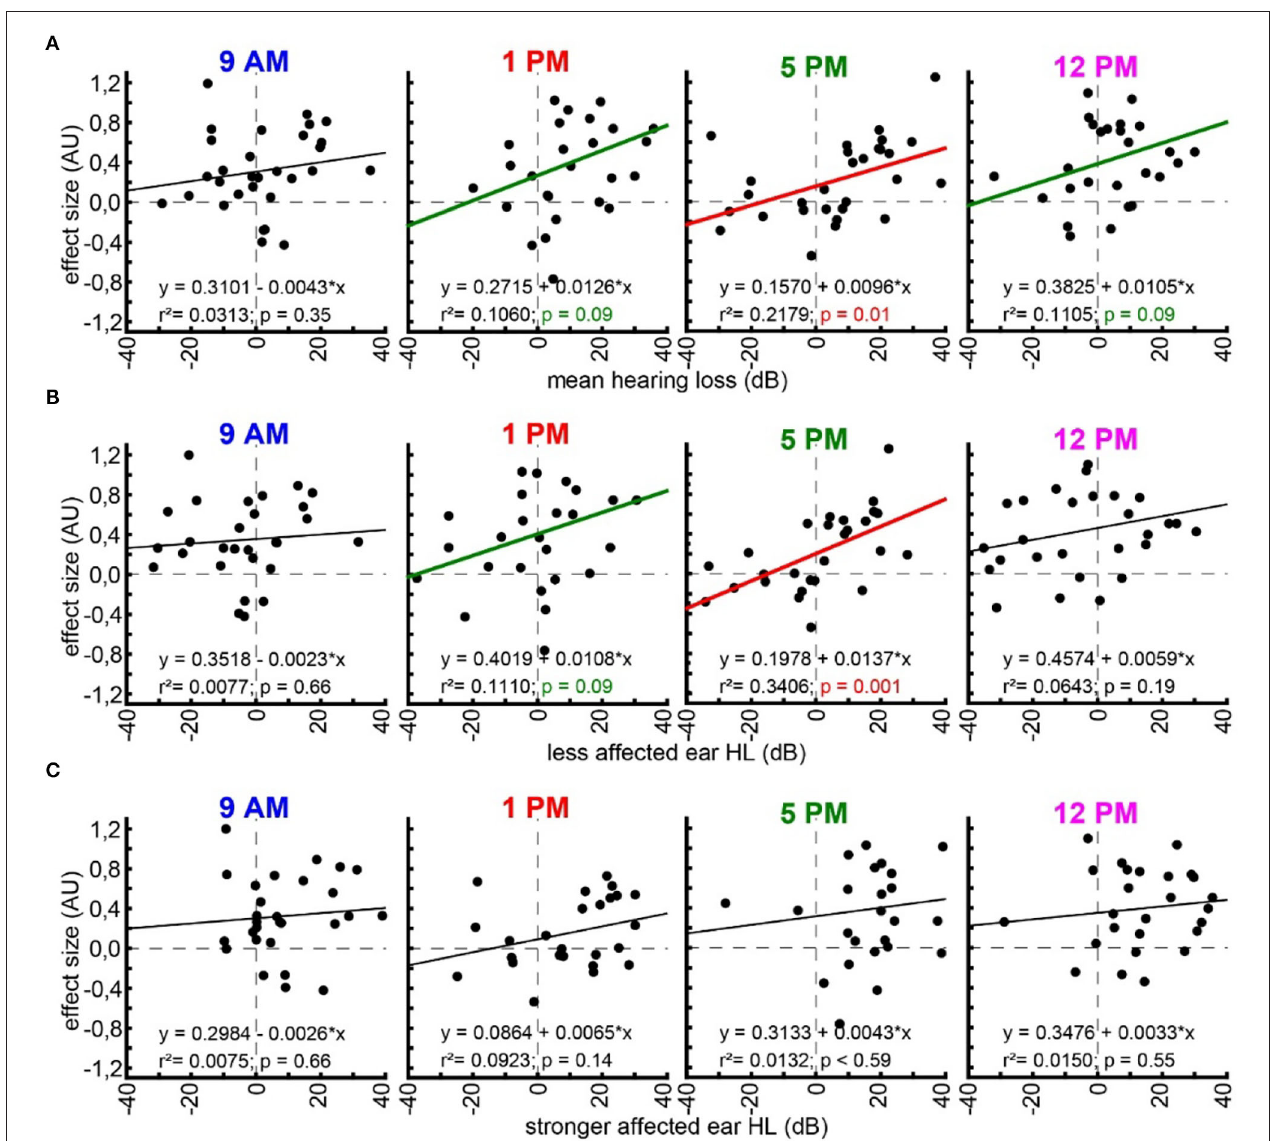
FIGURE 5 | Linear regression analyses of hearing loss and effect size. (A) Multiple linear regressions for effect size and mean binaural hearing loss for each trauma time group (panels from left to right). Linear regression formula, r ² -value, and p -value are given for each case. Black regression lines and p -values indicate no significant regression, green indicated a tendency, and red indicates a significant regression. (B) Multiple linear regressions for effect size and less affected ear hearing loss. (C) Multiple linear regressions for effect size and stronger affected ear hearing